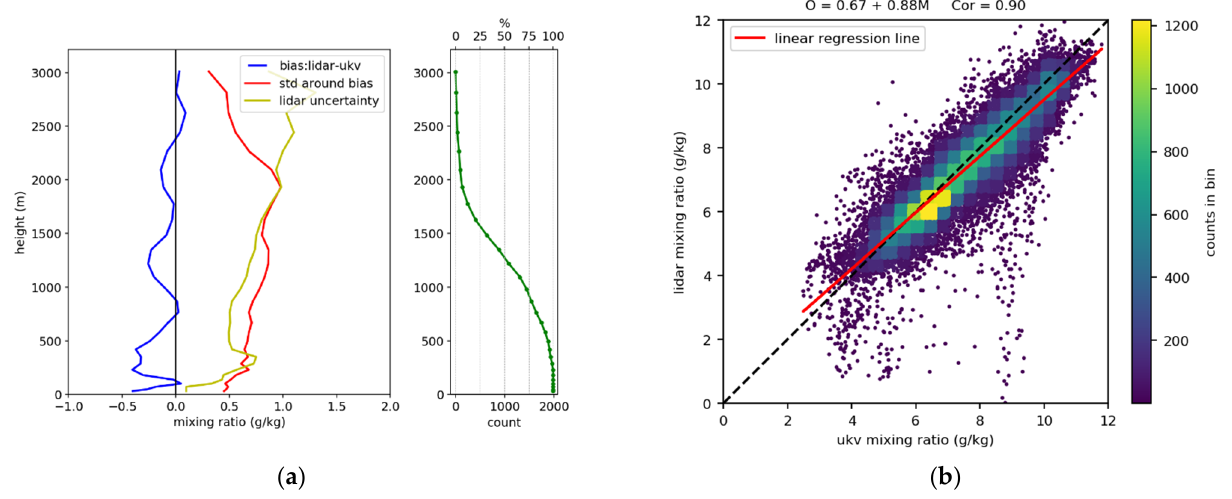
Figure 15. Comparison of BB-DIAL with the UKV model for the full assessment period. ( a ) Vertical profile of bias, standard deviation, BB-DIAL uncertainty and BB-DIAL data availability. ( b ) Scatterplot of BB-DIAL versus UKV, superimposed with a 2D histogram of the number of counts.